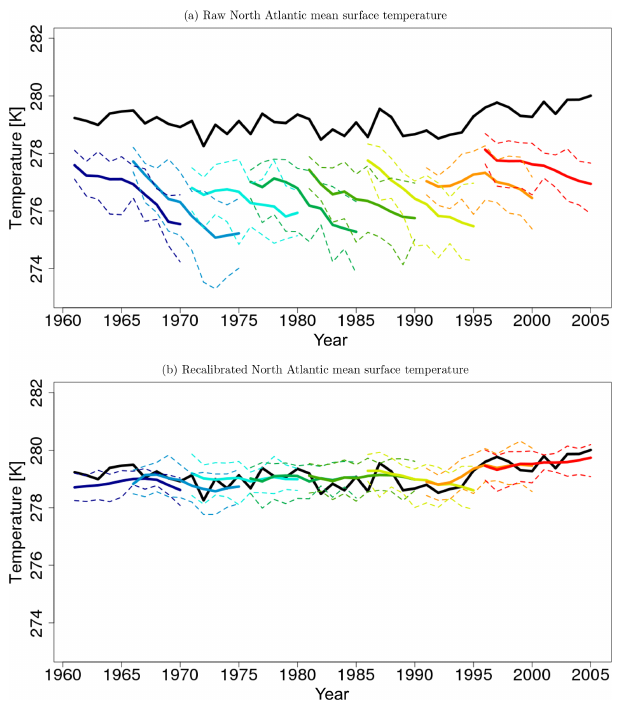
Figure 5. Temporal evolution of North Atlantic yearly mean sur- face temperature from the MiKlip prototype (a) before and (b) after recalibration with DeFoReSt. Shown are different start years with 5- year intervals (colored lines). The black line represents the surface temperature of NCEP 20CR. Units are in Kelvin